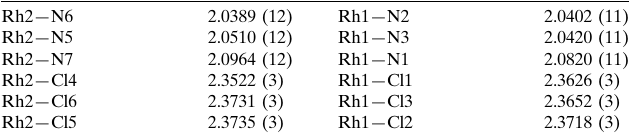
Selected bond lengths (A˚ ).